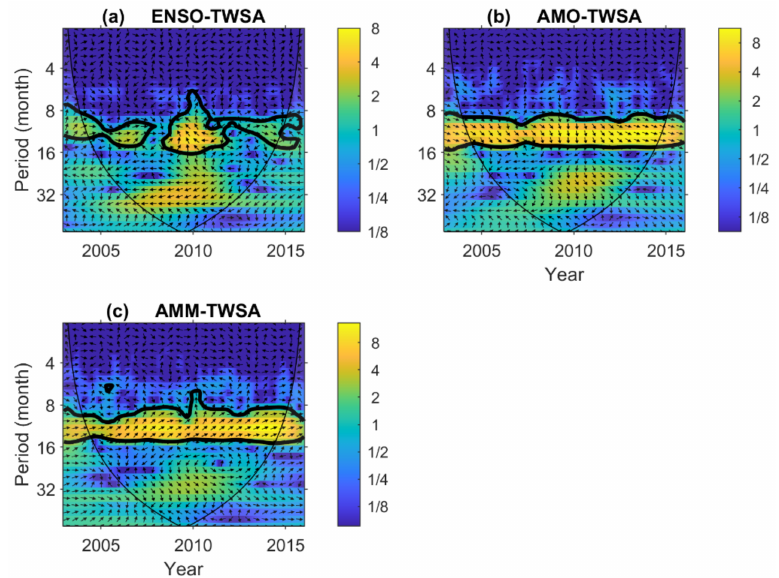
Figure 11. Cross wavelet transforms between TWSA VRB and ( a ) ENSO, ( b ) AMO and ( c ) AMM from 2003 to 2016 in the Volta River Basin. The relative phase relationship is denoted as arrows (with anti-phase pointing left, in-phase pointing right). The color bar on the right denotes the wavelet